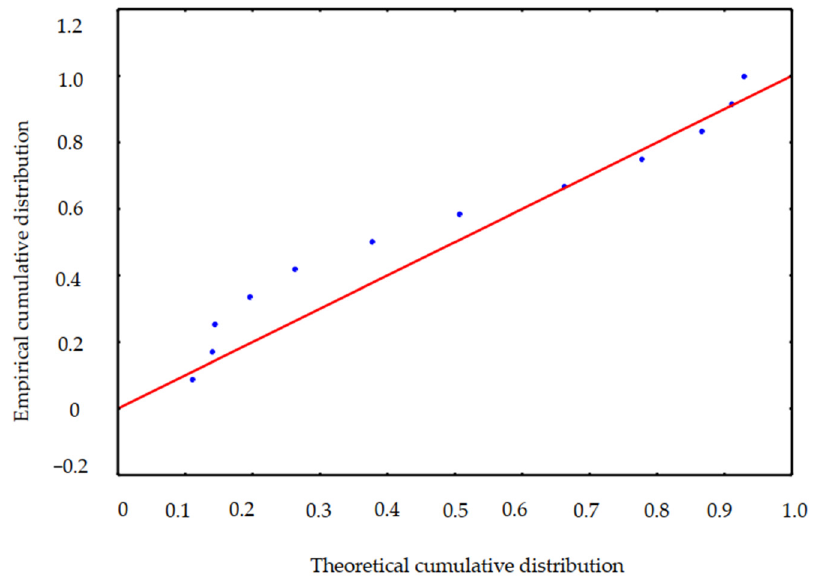
Figure 12. Plot of observed values (empirical cumulative distribution) versus expected frequencies (theoretical cumulative distribution).